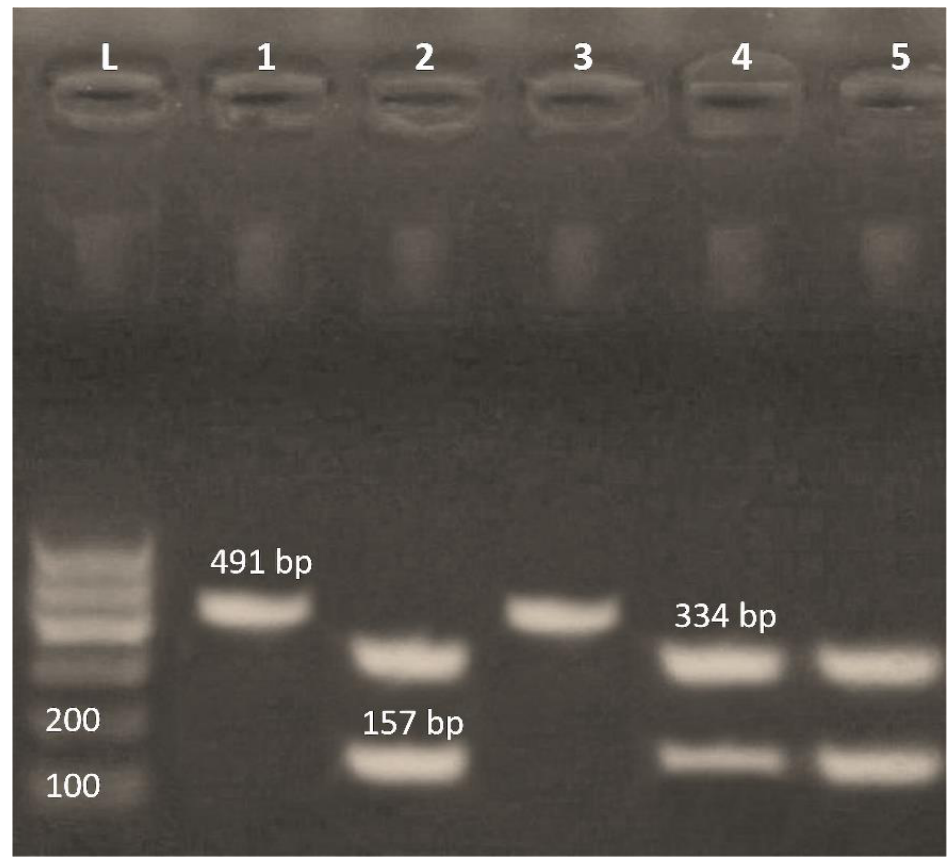
Figure 2. PCR-RFLP assay for differentiation of class 1 and class 2 integrons using Rsa I restriction enzyme. Lane L: 100-bp ladder; Lanes 2, 4 and 5 (334 bp and 157 bp) represent class II integrons; Lanes 1 and 3 (491 bp) represent class I integrons.